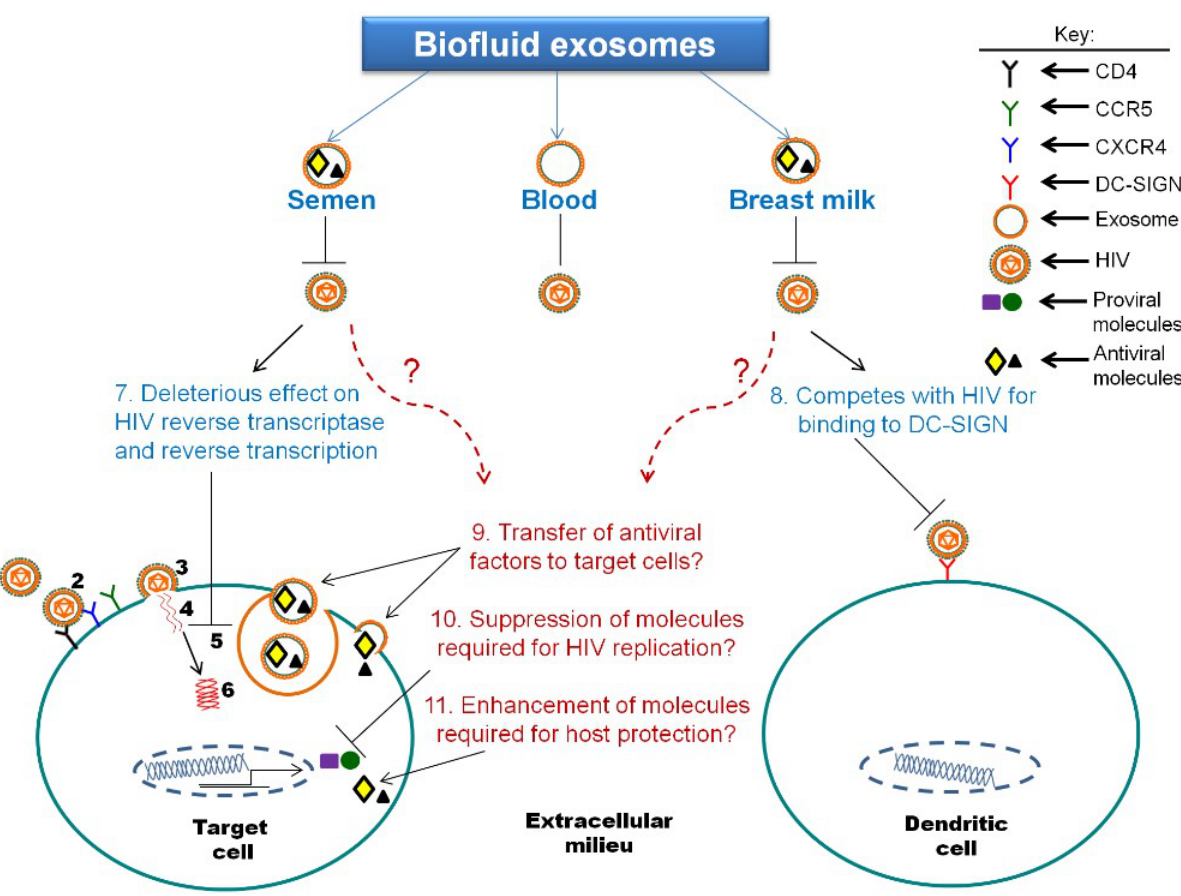
Figure 3. Biofluid derived exosomes modulate HIV-1 infection: ( 1 – 6 ) HIV-1 life cycle as defined in Figure 1